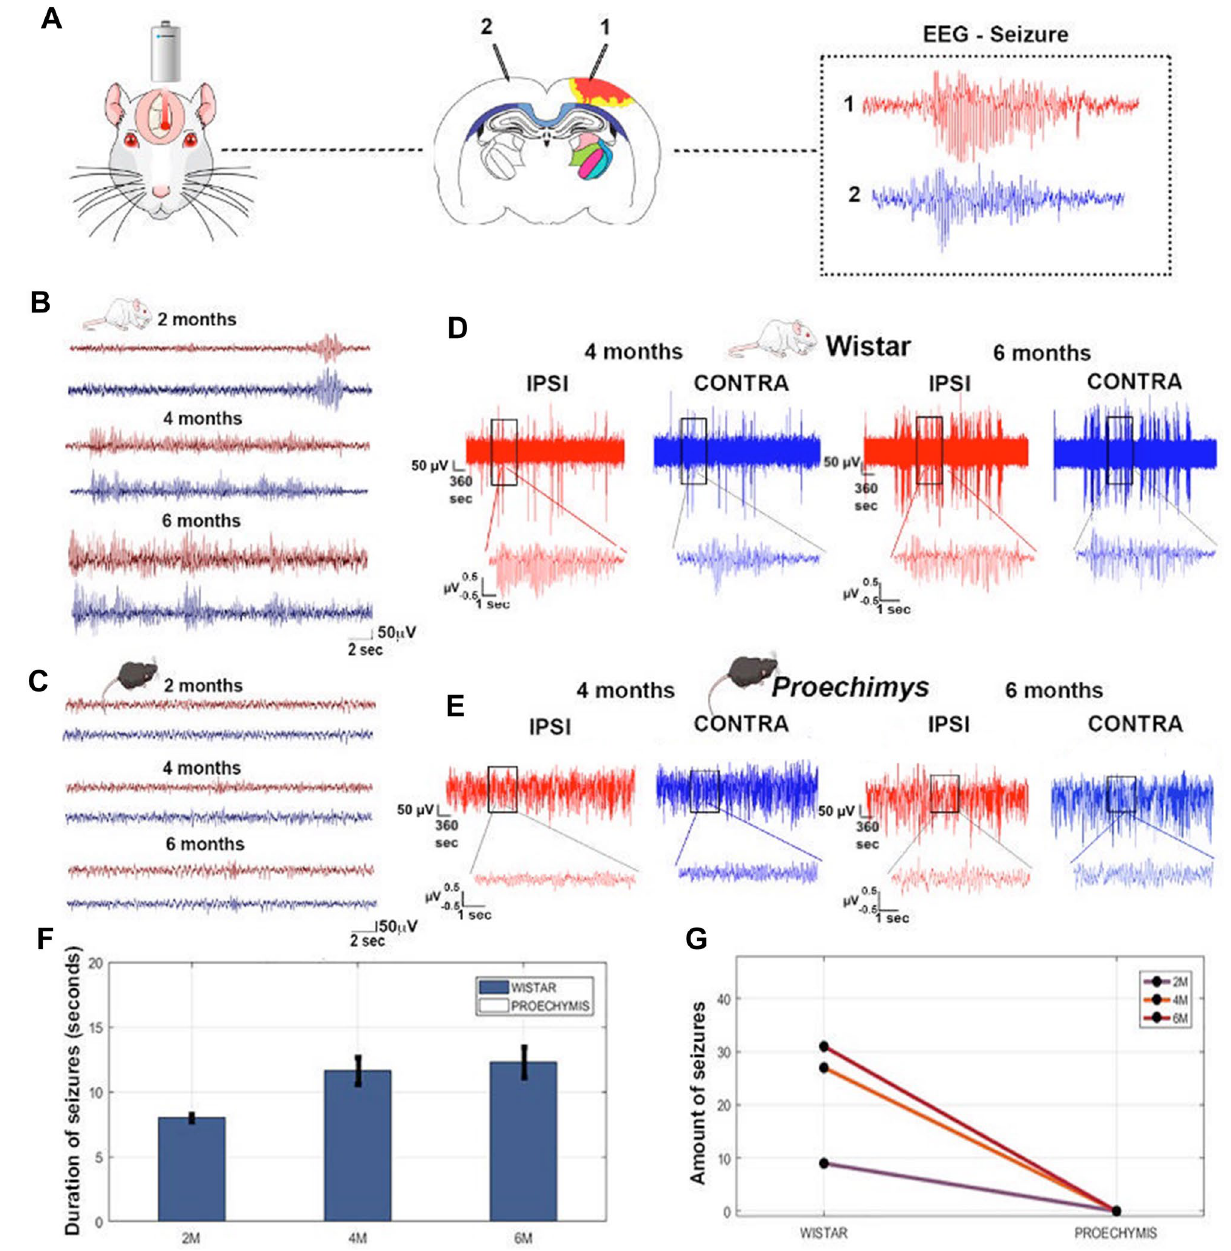
Figure 5. Long-term electrocorticographic monitoring after photothrombotic stroke in Proechimys and Wistar rats. ( A ) Schematic representation of stroke induction; the coronal brain section shows the position of the ipsilateral (1) and the contralateral (2) cortical recording electrodes; representative trace recordings of epileptiform activity are shown in the box, ipsilateral (red) and contralateral (blue) to the lesion. ( B ) Representative ECoG tracings showing epileptiform activity recorded at 2, 4 and 6 months after stroke in Wistar rats (n = 8). Note temporal changes in ECoG pattern. ( C ) Representative post-stroke ECoG recordings in Proechimys . The lesion does not result in epileptiform activity in this animal species (n = 8). ( D ) 1-h compacted ECoG trace from Wistar at 4 and 6 months after stroke. Note the increased recurrent epileptic burst discharges at 6 months as compared with previous ECoG recording in Wistar rats. A representative ECoG trace from a Wistar rat induced by photothrombosis showed recurrent epileptic burst discharges. ( E ) 1-h compacted ECoG trace from Proechimys at 4 and 6 months after stroke. No difference is observed in EcoG recording in 6 and 6 months after brain injury. A representative ECoG trait of Proechimys rodent after stroke showing unchanged ECoG signaling. ( D,E ) Extended view of single-cluster brain activity of the box. Time and amplitude are given by calibration 2 s—50 µV in the bottom in the ECoG recording samples. ( F ) Duration of seizures at 2, 4 and 6 months after stroke. Note that seizure activity was observed only in Wistar rats. Graphs are represented as median with 95% CI ( G ) Amount of seizures at 2, 4 and 6 months after brain injury. Graph is represented using absolute values. Figure was created in the Mind the Graph platform http:// www. mindt hegra ph. com under Creative